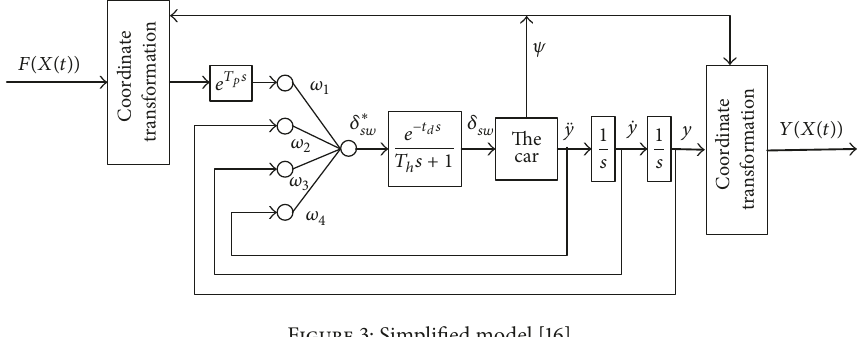
Figure 3: Simplified model [16].